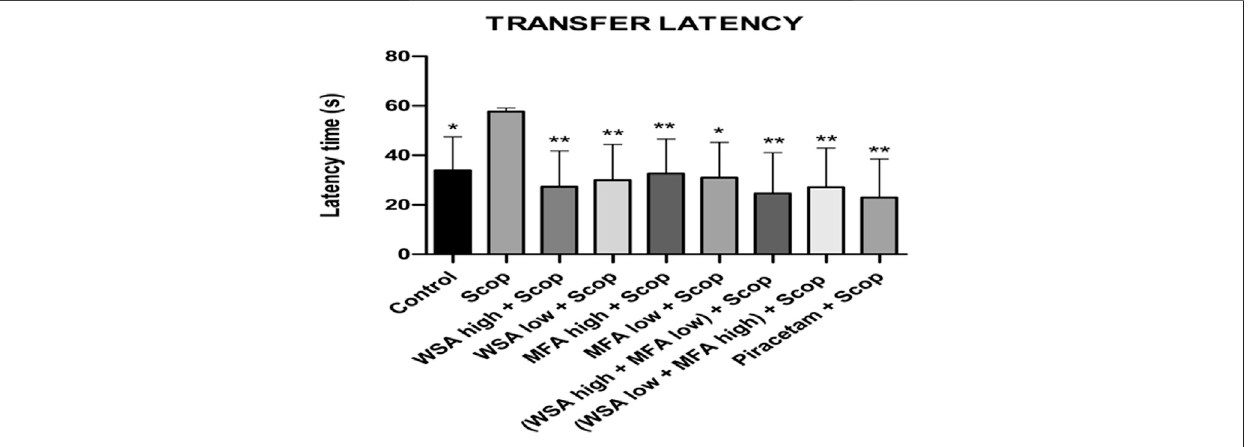
FIGURE 7 | Dynamics of transfer latency in the spatial acquisition trial in reference memory test in male wistar rats in Elevated plus maze. There were three days acquisition trials with 30s inter-trial intervals and each data point is the mean of four trials. The data is represented as Mean ± SEM. Markers represent the differences. Each line in the plot shows the average of six mice in each group. The data is represented as Mean ± SEM. Markers represent the differences ** p < 0.001 and * p < 0.5 when compared to Scop group; analyzed by one-way ANOVA followed by Dunnett ’ s Multiple Comparison Test.